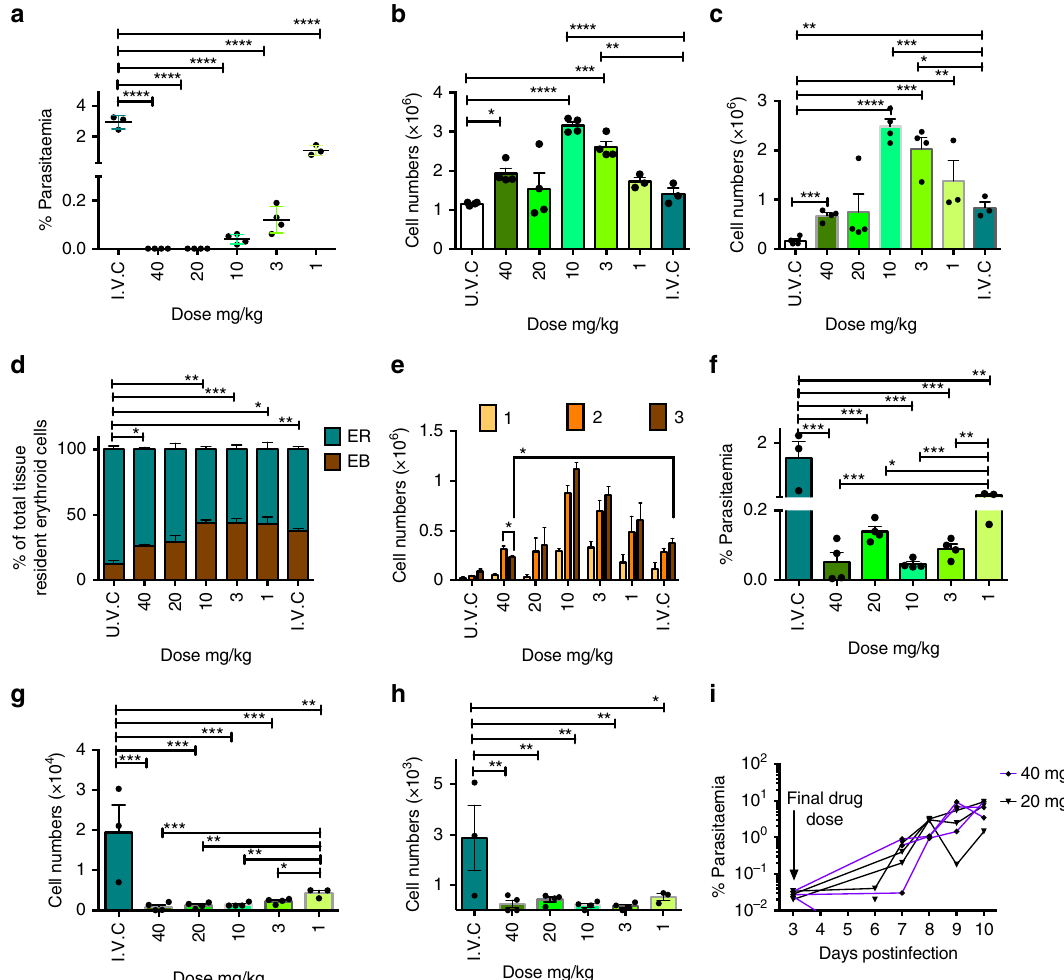
Fig. 4 P. berghei infection persists within splenic early reticulocytes after ART clearance of peripheral blood infection. Groups of BALB/c mice ( n = 7) received four doses of ART and were randomly sampled on day 4 pi, 24 h after the fi nal doses (infected and uninfected vehicle controls; IVC and UVC, respectively. 1 mg/kg n = 3, 3 mg/kg − 40mg/kg n = 4). a ART doses of 20 and 40 mg/kg cleared peripheral blood parasitemia of animals culled on day 4 pi. b Numbers of splenic ER in response to ART. c Numbers of splenic EB in response to ART. d The proportion of EB and ER in the spleen. e The proportions of EB developmental stages in response to ART. f Parasitemia in splenic ER during ART treatment. g Parasite numbers in splenic ER on day 4